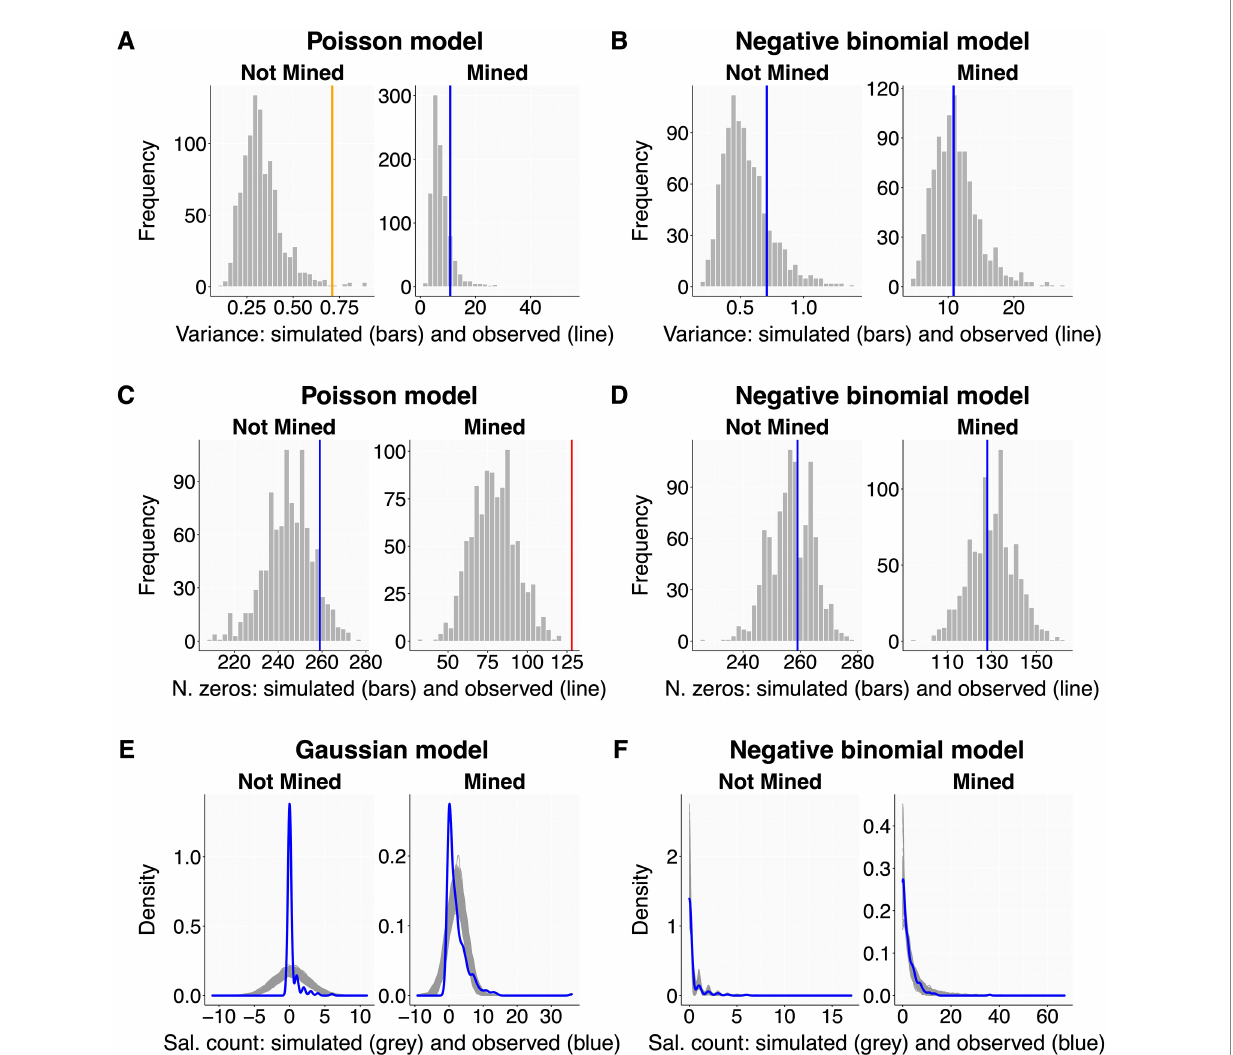
FIGURE 3 Posterior predictive checks - examples. All plots show observed values or data distributions (thick colored lines) in relation to those obtained from 10,000 simulations of raw datasets from the model. Each panel is split by a categorical predictor with two levels (sites without and with mining activity). The left column shows clear deviations between observed and simulated data for dispersion (A) , number of zeros (C) , and overall data distribution (E) . The right column has all issues solved by changing distribution family from Poisson to negative binomial for (B) and (D) , and from Gaussian to negative binomial for (F) . A Gaussian distribution was here chosen only to create a clear deviation for display purposes. Dataset as in Figure